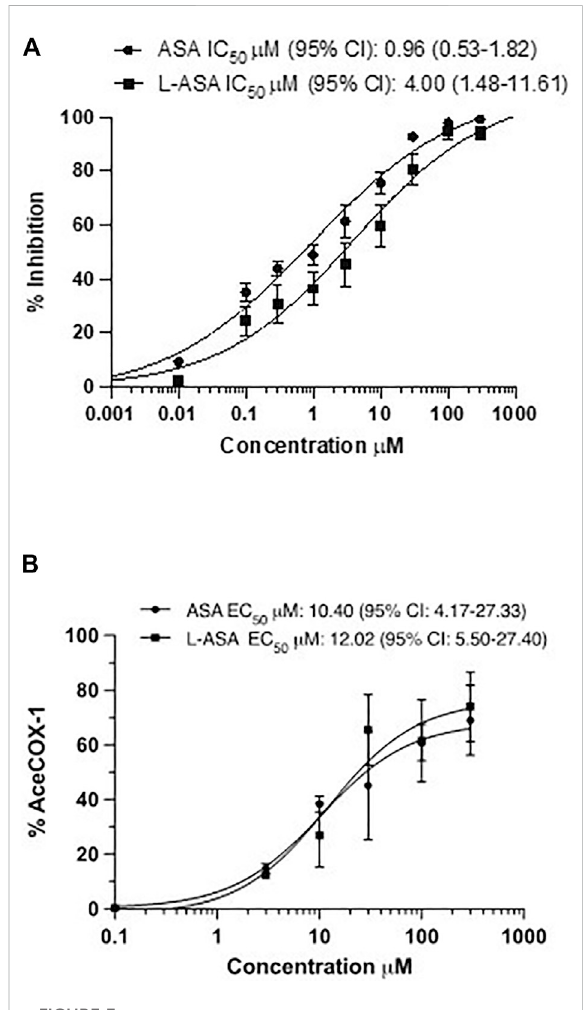
FIGURE 3 Effects of ASA and L-ASA on the biosynthesis of TXB 2 and the extent of acetylation of COX-1 at Serine529 in washed human platelets. (A) Washed platelet suspensions (0.5 ml containing 1 × 10 8 cells) were incubated with DMSO or diluent or ASA or L-ASA for 30 min at room temperature; then CaCl 2 2 mM and MgSO 4 1 mM were added for 2 min at room temperature, and plateletswerestimulatedwithAA10 μ Mfor30 minat37 ° C; fi nally, platelet suspensions were centrifuged, and supernatants were collected to assess TXB 2 levels by immunoassay (validated by comparison with LC-MS/MS); results are reported as % inhibition from baseline values (mean ± SD, n = 4 – 6). (B) Washed human platelet suspensions were incubated for 60 min with DMSO or diluentorincreasingconcentrationsofASAorL-ASAat37 ° C;then, platelets were lysed, and the quanti fi cation of acetylated and unacetylated COX-1 at Serine529 was assessed by LC-MS/MS, as described in materials and methods; the percentage of COX-1 acetylation to total COX-1 was calculated (%AceCOX-1). The data are reported as mean ± SD (n = 3 separate experiments). Concentration-response curves were fi tted, and IC 50 or EC 50 values with 95% Con fi dence Interval (CI) values were